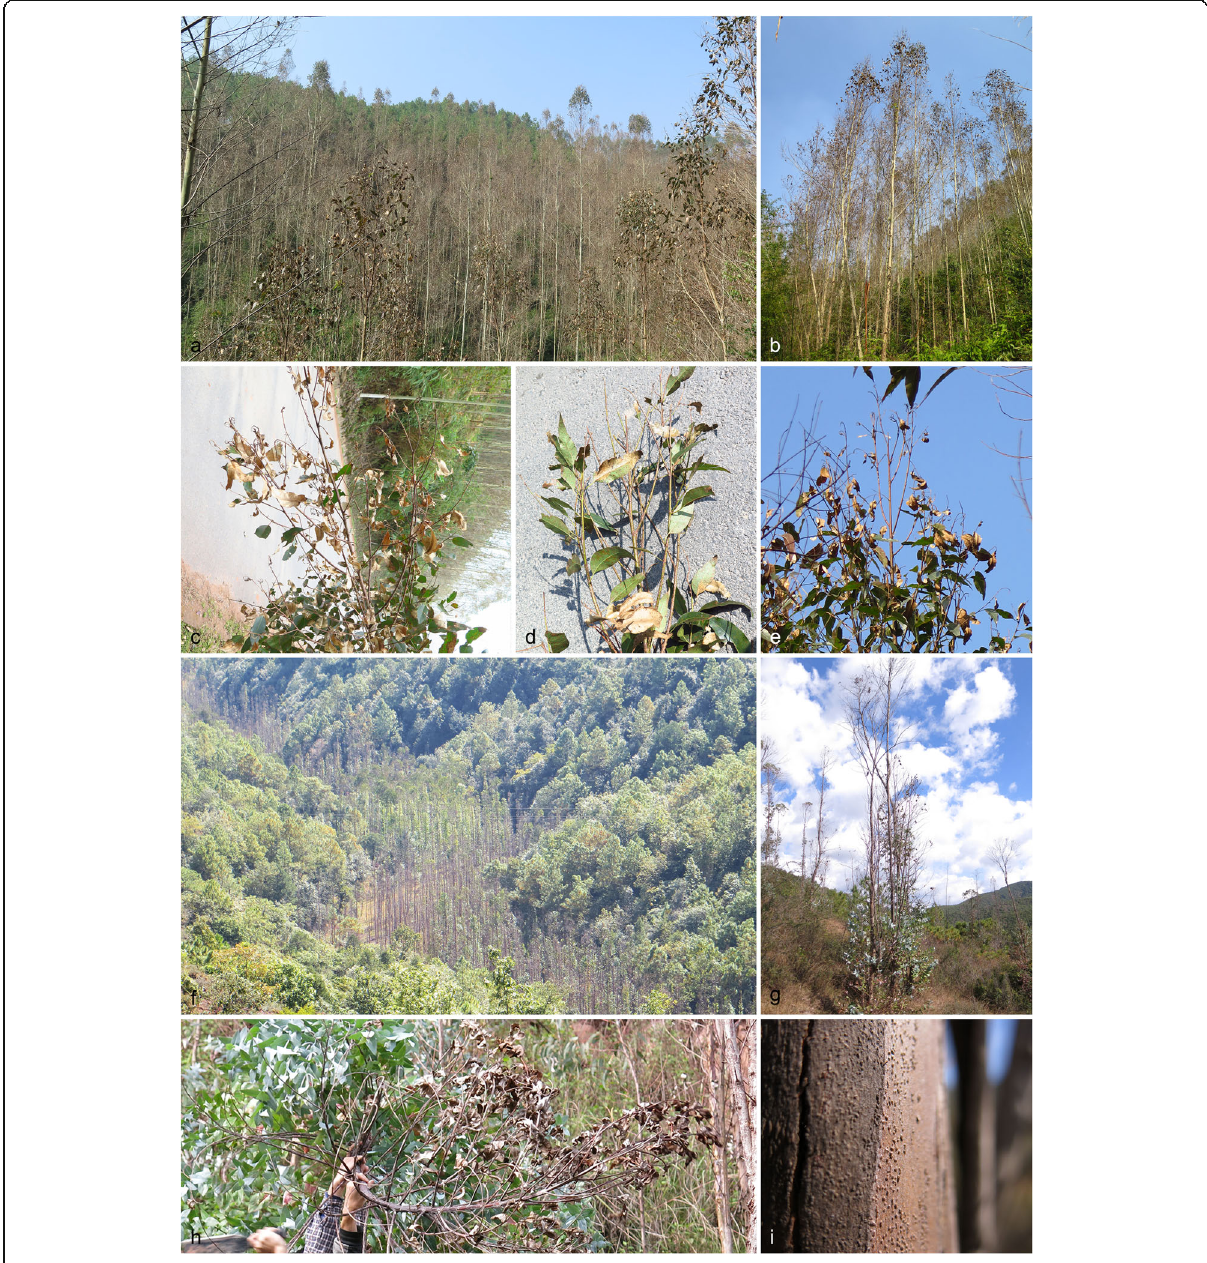
Fig. 1 Disease symptoms on Eucalyptus trees associate with Botryosphaeriaceae in YunNan Province. a, b . die-back of E. urophylla × E. grandis hybrids; c – e . branch and twig blight of E. urophylla × E. grandis hybrids. f – h . die-back of E. globulus ; i . fruiting structures on an E. globulus